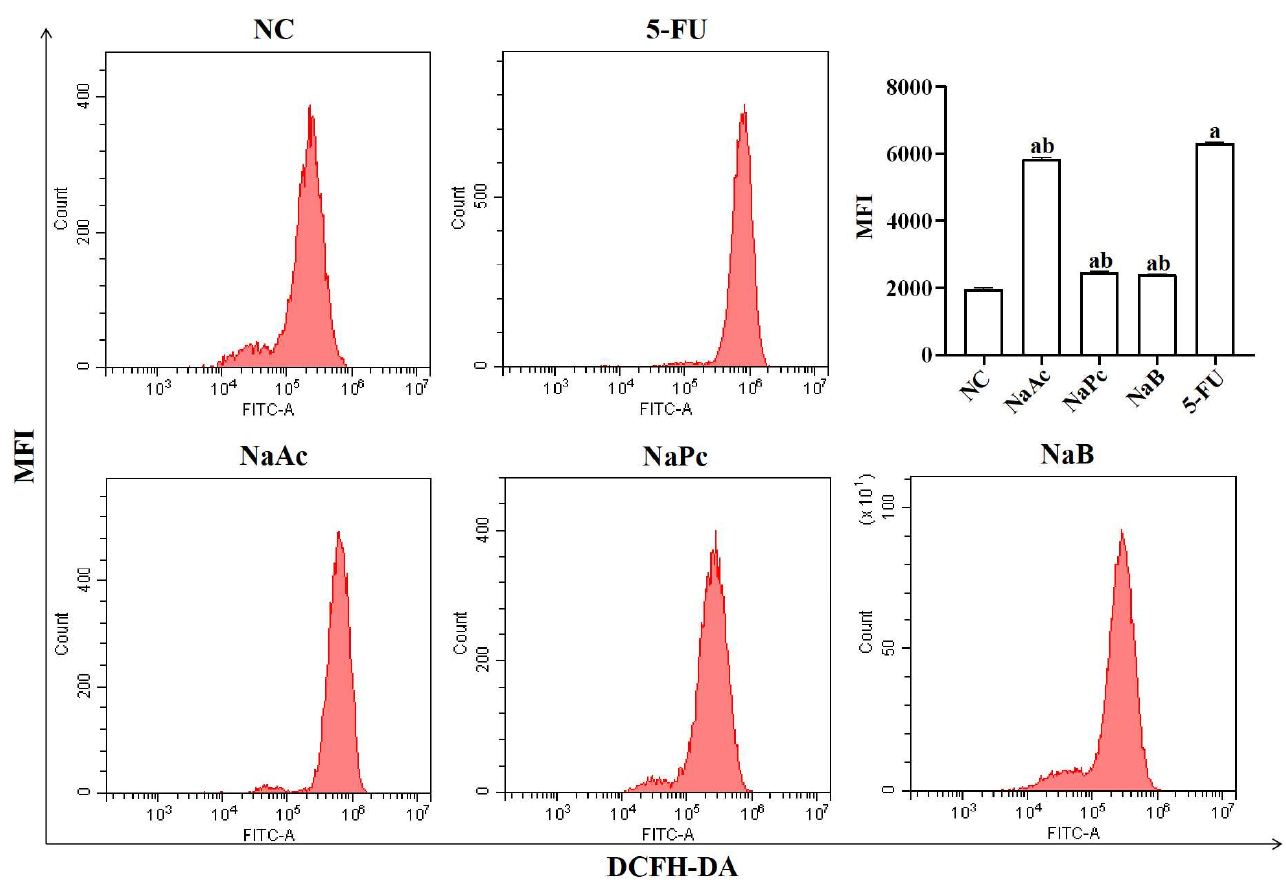
Figure 1. Detection of intracellular ROS expression in THP-1 cells by flow cytometry ( n = 3/group). The three main SCFAs (NaAc, NaPc, and NaB) can significantly inhibit the ROS expression induced by 2.5 mmol/L of 5 − FU. Each experiment was repeated at least three times. Data are expressed as the mean ± SEM. a— p < 0.05, vs. the NC group; b— p < 0.05, vs. the 5 − FU group.